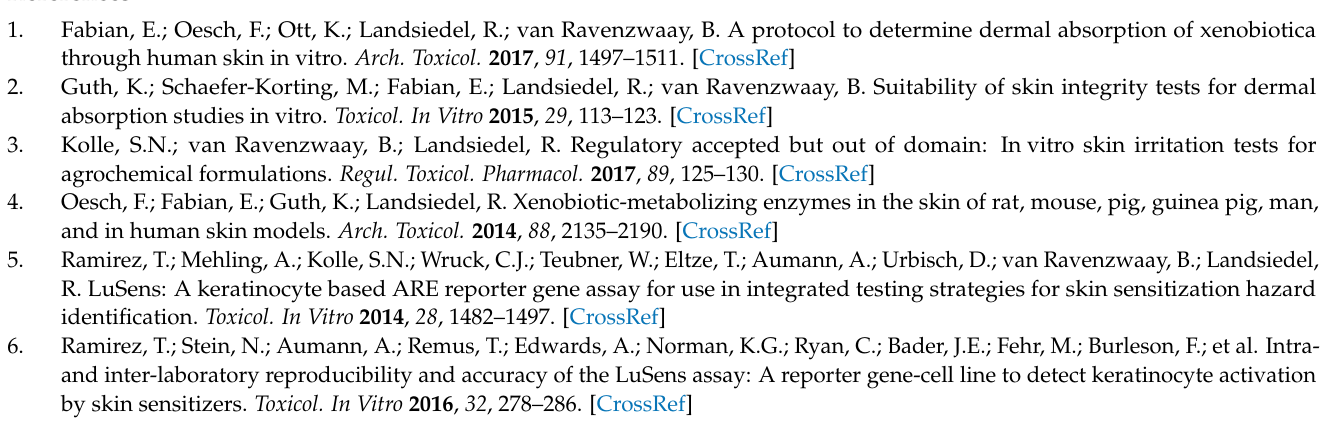
Control charting data for the PDA fluorescence assay, Figure S9. Comparison of values obtained from the PDA absorbance and PDA fluorescence percentage depletion for test compounds, Table S1. Chemicals and Alerts, Table S2. New and Historical Chemical Data, Table S3. Summary of in-process control measurements in plate design, Table S4. Summary of robustness testing results, Table S5. Bubble Test Data, Table S6. Specifications for the EASA assay, Table S7. Results from testing the test compounds with the 4-nitrobenzenethiol (NBT) absorbance assay analyzed using a Bayesian model, Table S8. Results from testing the test compounds with the pyridoxylamine (PDA) absorbance assay analyzed using a Bayesian model, Table S9. Results from testing the test compounds with the pyridoxylamine (PDA) fluorescence assay analyzed using a Bayesian model, Table S10. Results from testing the test compounds with the 4-nitrobenzenethiol (NBT) absorbance assay analyzed using a frequentist model, Table S11. Results from testing the test compounds with the pyridoxylamine (PDA) absorbance assay analyzed using a frequentist model, Table S12. Results from testing the test compounds with the pyridoxylamine (PDA) fluorescence assay analyzed using a frequentist model, Table S13. NBT Bayesian Analysis, Table S14. PDA Absorbance Bayesian, Table S15. PDA Fluorescence Bayesian Analysis; Supplementary Spreadsheets: NBT Data Calculator, PDA Fluor Data Calculator, Raw Data for NBT, Raw Data for PDA Absorbance, Raw Data for PDA Fluorescence, Example of Completed